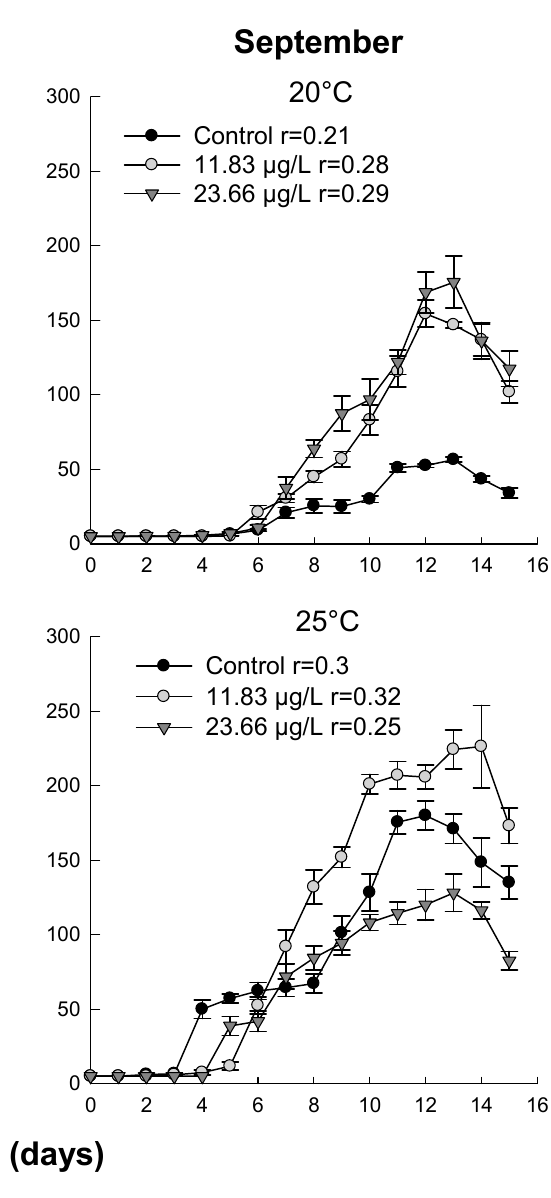
Figure 2. Population growth of Daphnia pulex exposed to cyanobacterial extracts from blooms of Microcystis (January) and Woronichinia (September) at 20 °C and 25 °C. Shown are the means ± SE based on four replicate recordings. The population growth rate ranged from 0.18 to 0.42 d ‐ 1 for the extracts from M. ae ‐